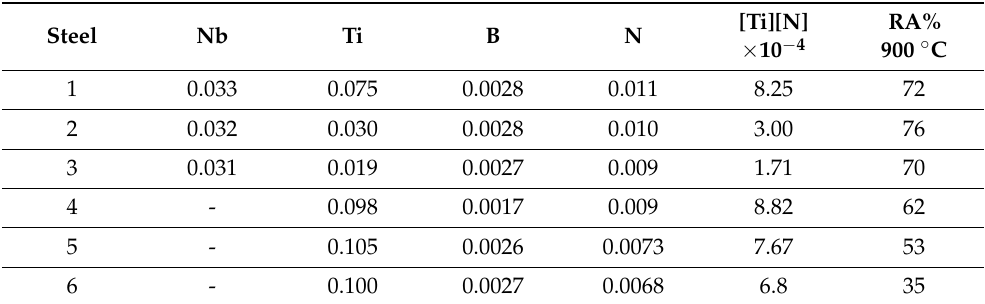
Figure 32. Influence of Nb on the hot ductility of high Al, Ti-B containing TWIP steels. The com- position of the steels (1–6) is given in Table 4. Cooling rate and strain rate were 60 K/min and 3 × 10 − 3 s − 1 , respectively [66]. Table 4. Compositions wt.per.cent of steels in Figure 32 together with the Product of [Ti][N] and RA value at 900 ◦ C